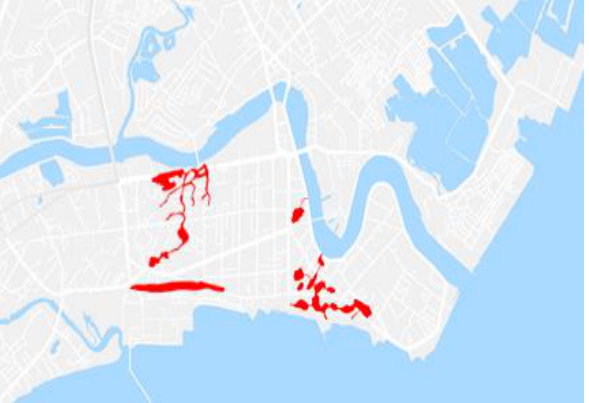
Figure 8. Vanished bodies of water (red) in Iloilo City.